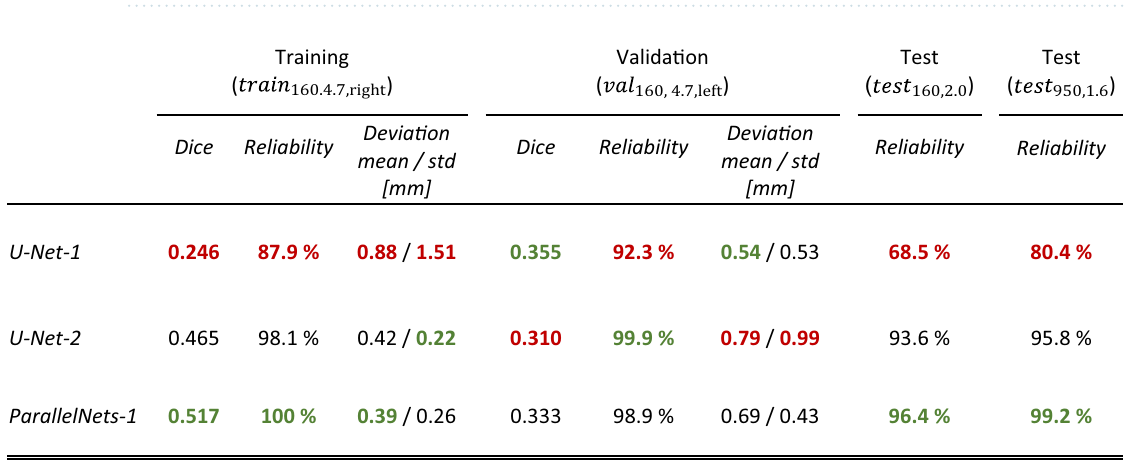
Figure 4. Grad-CAM attention heatmaps for the three trained networks (columns) and three different input samples (rows). The segmented crack tips are shown in gray.